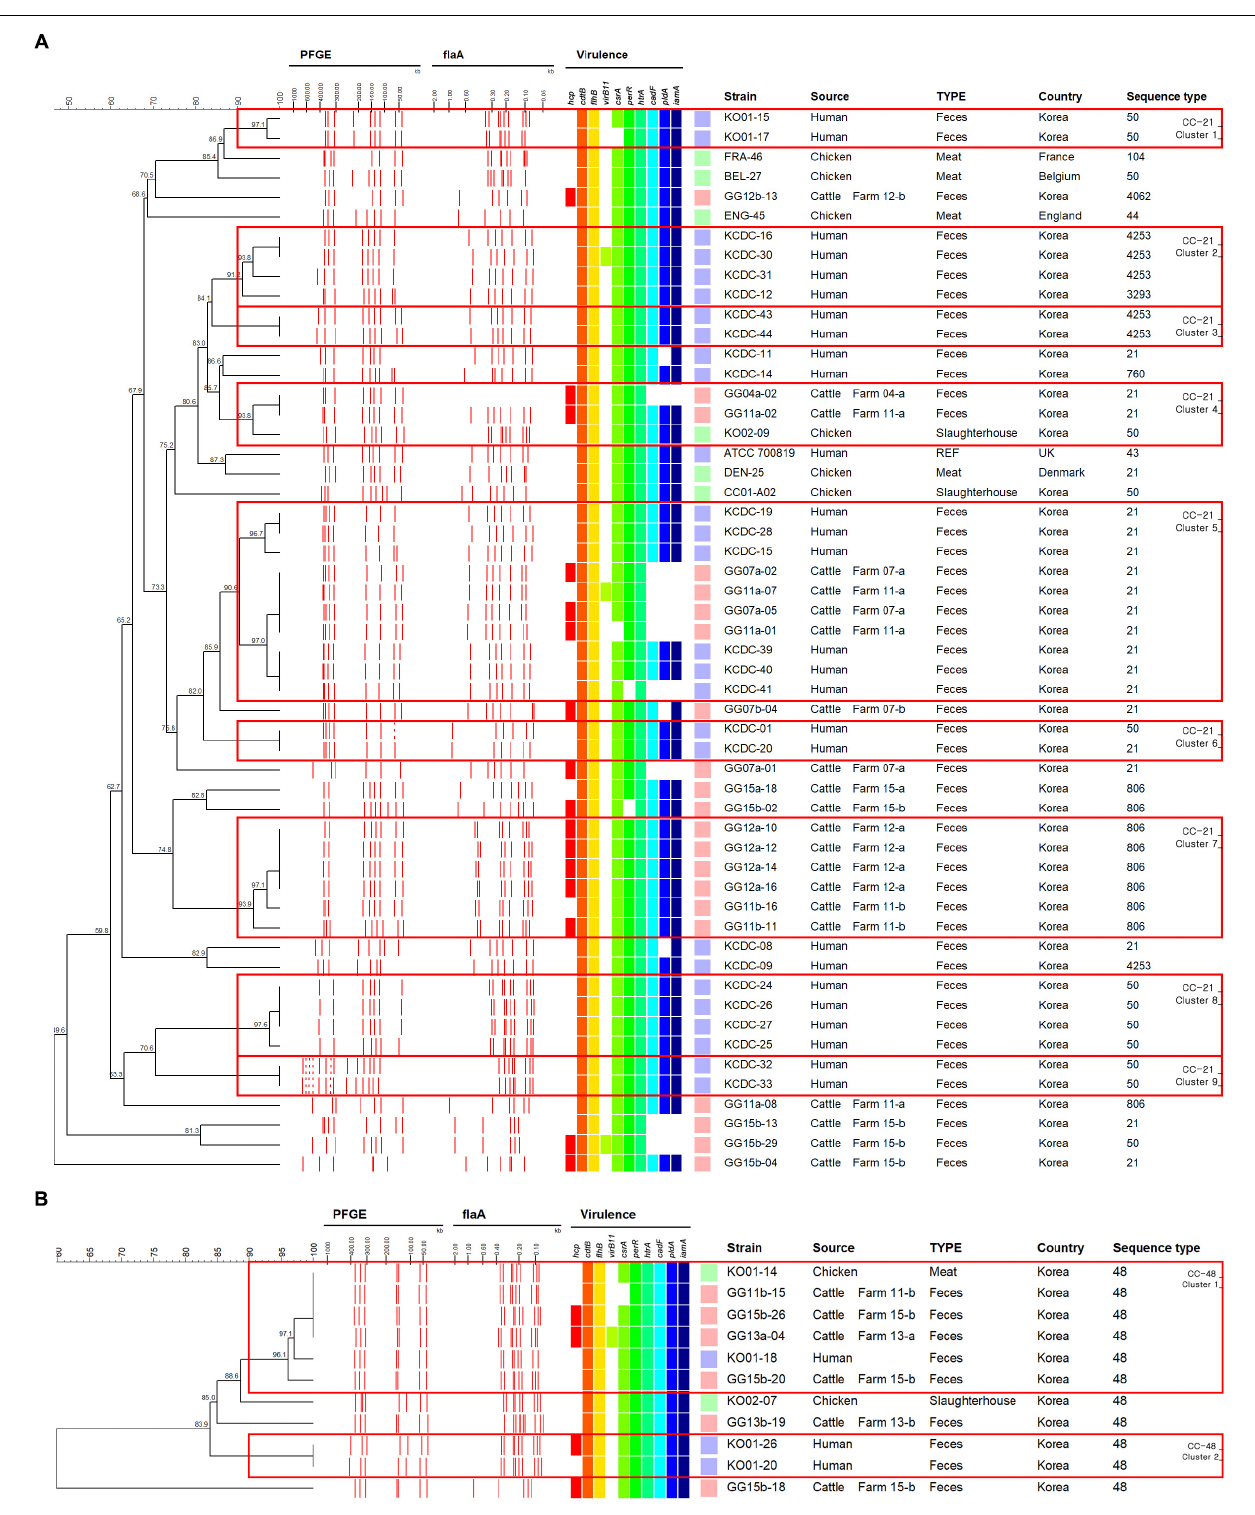
Frontiers in Microbiology |